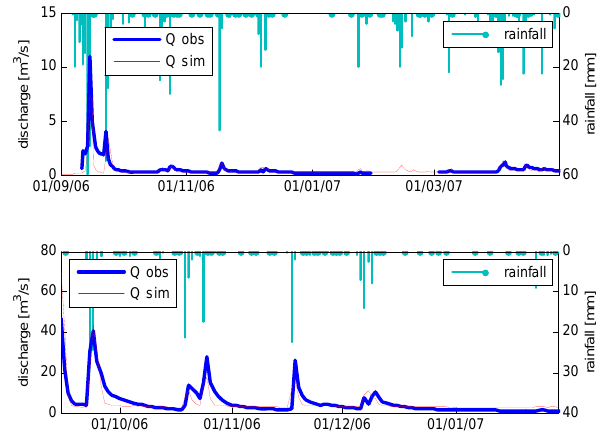
Fig. 5. River discharge ( Q obs : observed vs. Q sim : simulated) for Figure 5: River discharge (Q obs: observed vs. Qsim: simulated) for the Villacarli badlands the Villacarli badlands (11 September 2006–30 April 2007, top) and (2006/09/11-2007/04/30, top) and the Isábena (2006/09/15-2007/01/29, bottom) the Is´abena (15 September 2006–29 January 2007, bottom) catch- catchment